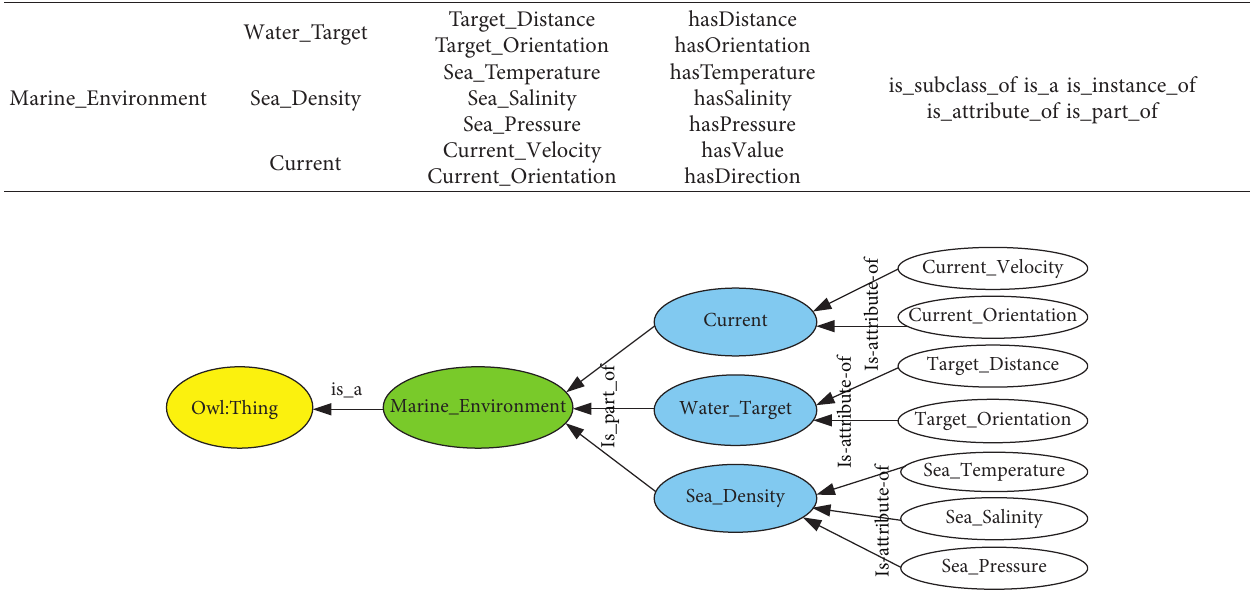
Figure 2: Structure of the marine environment application ontology. Table 3: Classes and attributes in the UUV platform status application ontology.